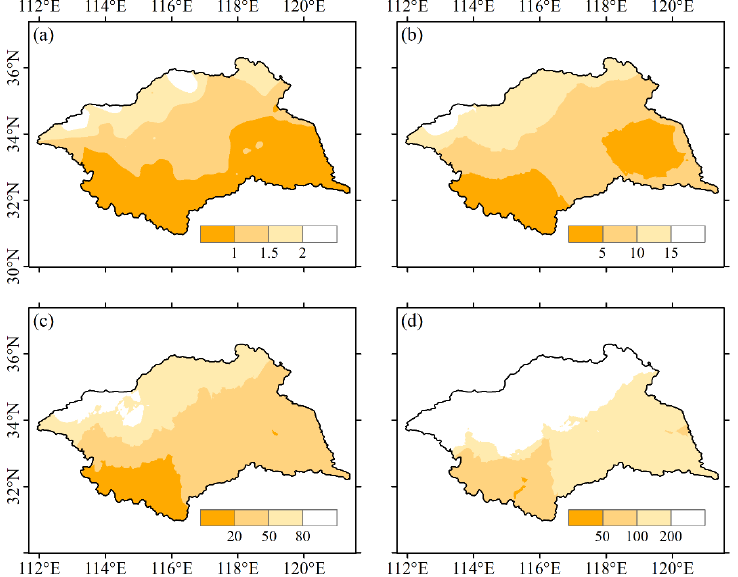
Figure 20. Spatial patterns of return periods (years) of ( a ) G1, ( b ) G2, ( c ) G3, and ( d ) G4 CEDNP events based on the copula method.